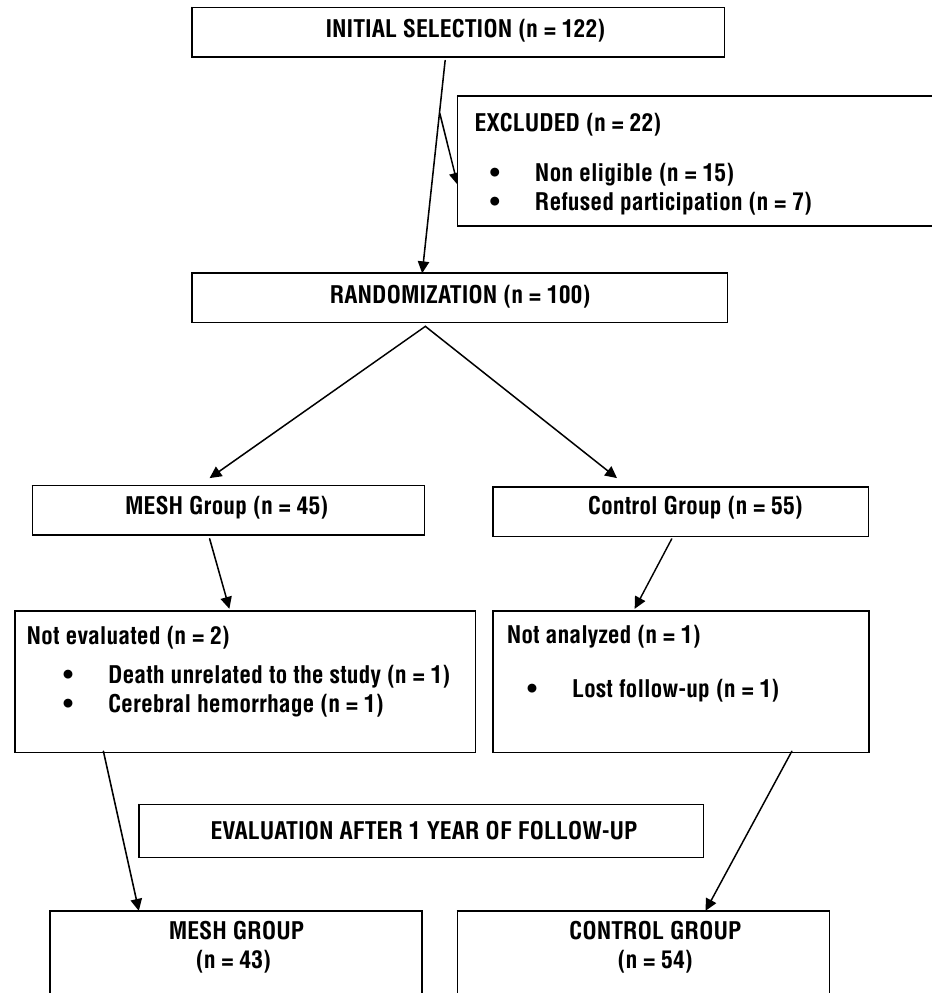
Figure 1 - Patient flow chart, randomization and group